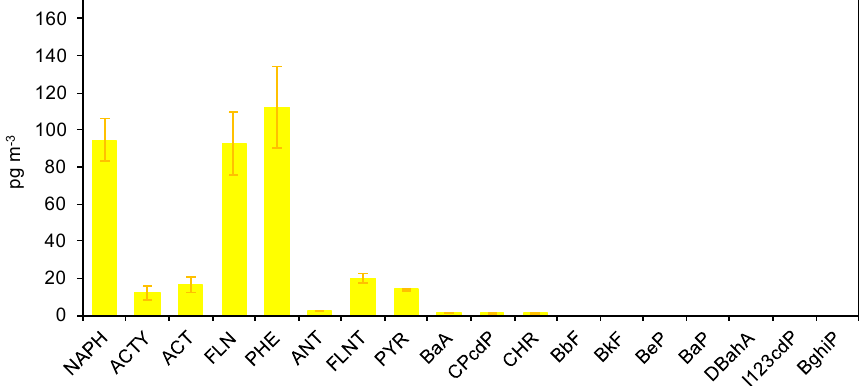
Figure 11. PAHs pattern in gas phase during AREX2011.